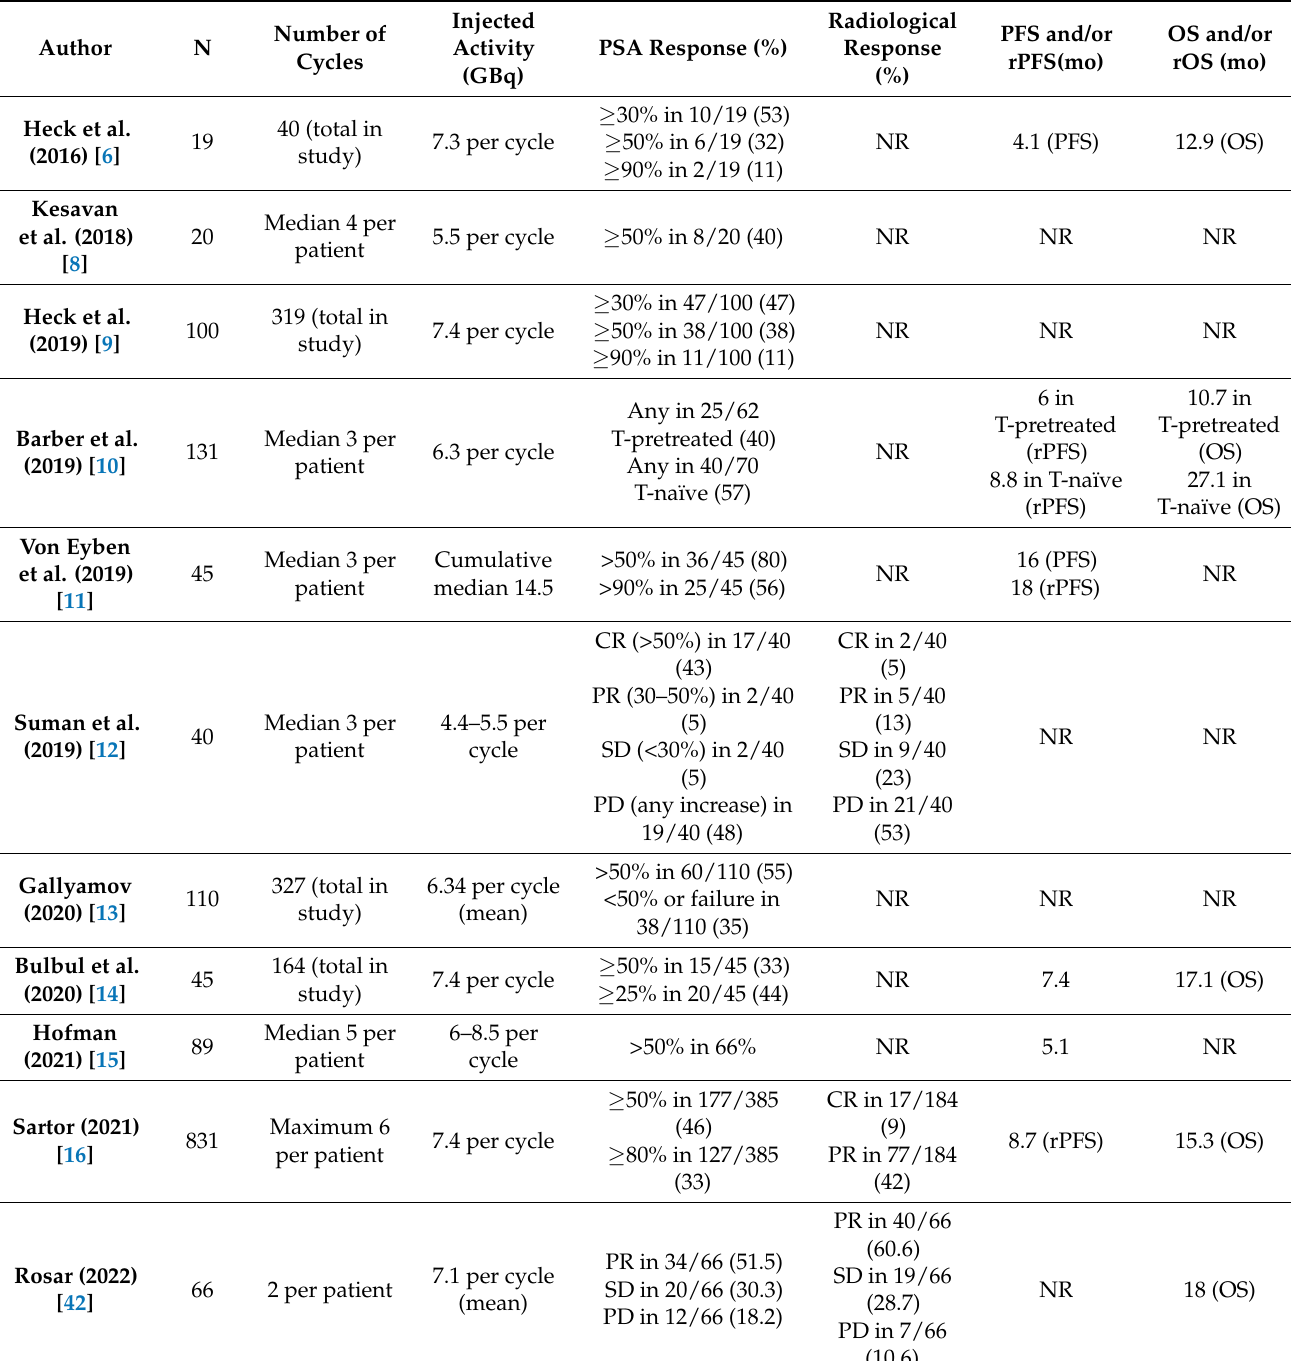
Table 1. Summary of 177Lu-PSMA